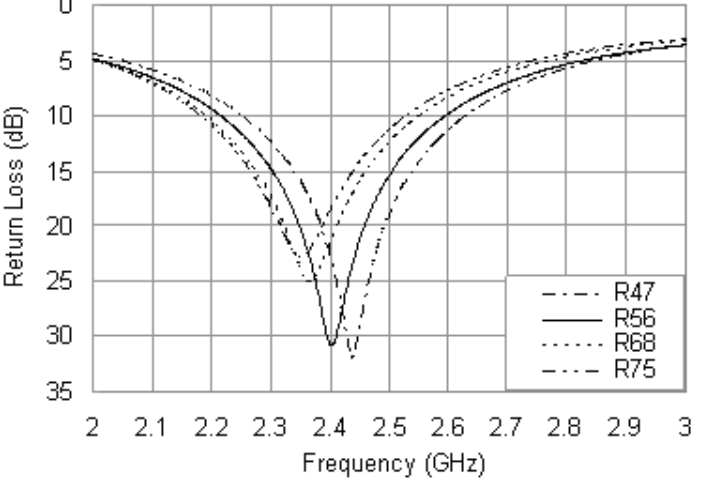
Figure 5. Simulated return loss curves with different values of R